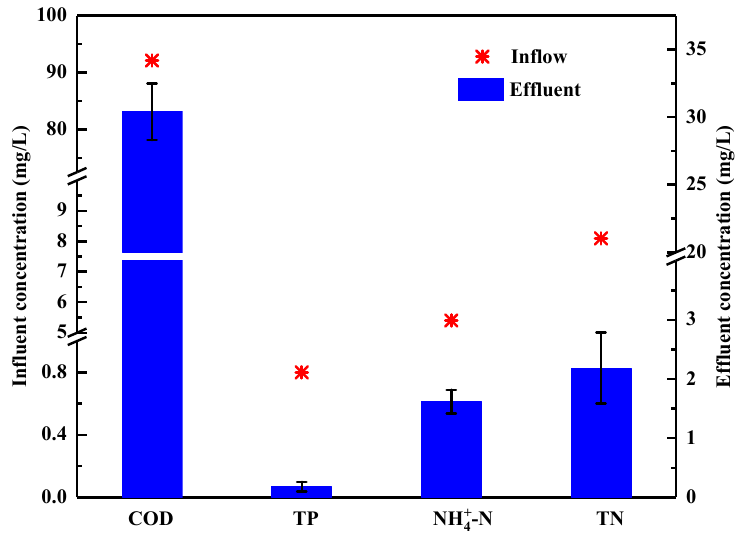
Figure 8. Concentrations of various pollutants in the effluent of a porous asphalt pavement-bioretention storage tank green roof (PBT-GR) system that was used to treat domestic grey water (n = 6).